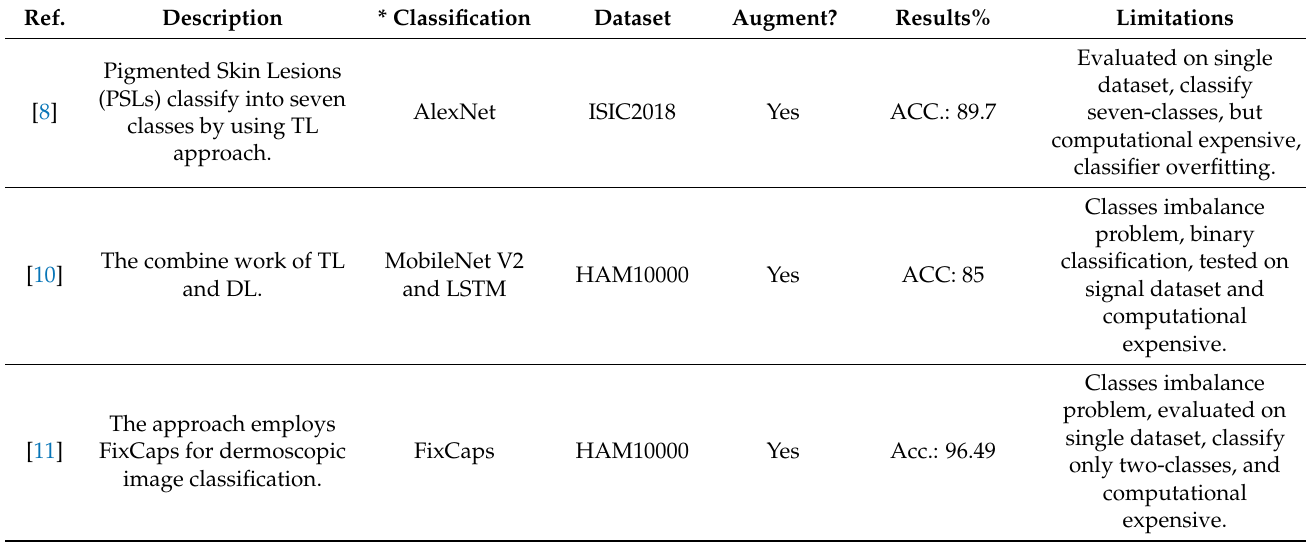
Table 1. State-of-the-art studies to diagnosis PSLs by using pretrained TL models.